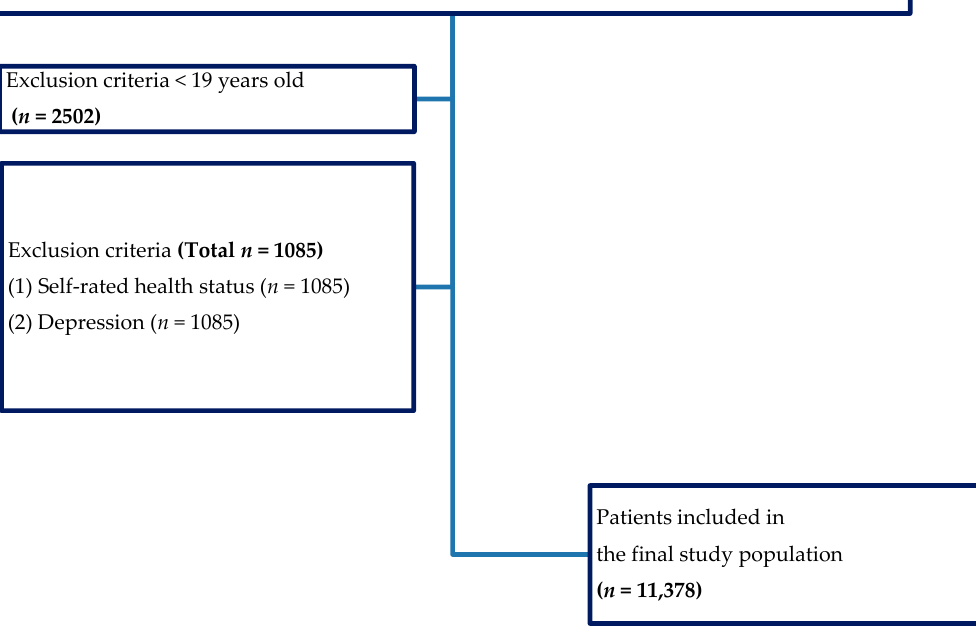
Figure 1. Flowchart of the study population. Abbreviations: KHPS = Korea Health Panel Survey.